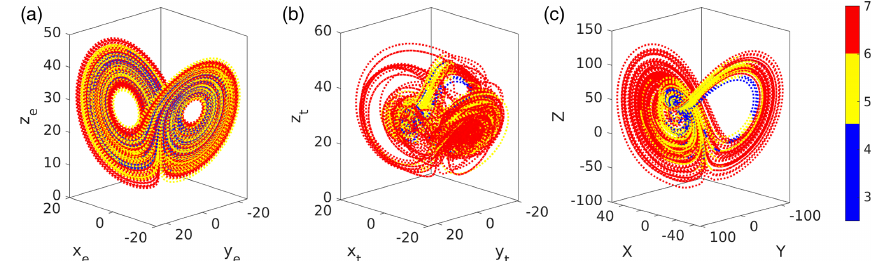
Figure 4. Local Kaplan–Yorke dimension plotted along the trajectory in phase space for the extratropical atmosphere (a) , tropical atmo- sphere (b) , and ocean (c)